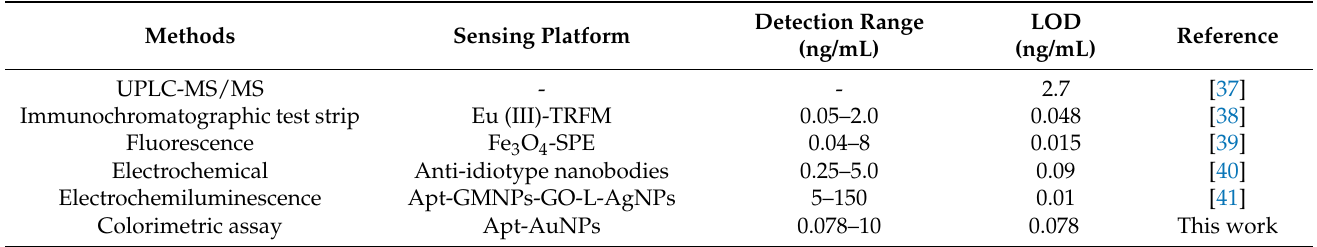
Table 1. Comparison of the developed colorimetric method with other different detection methods for AFM1 determination.